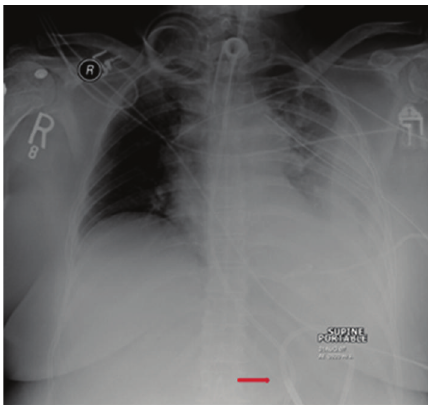
Figure 41: A CXR showing an NGT forming a loop within the fundus of the